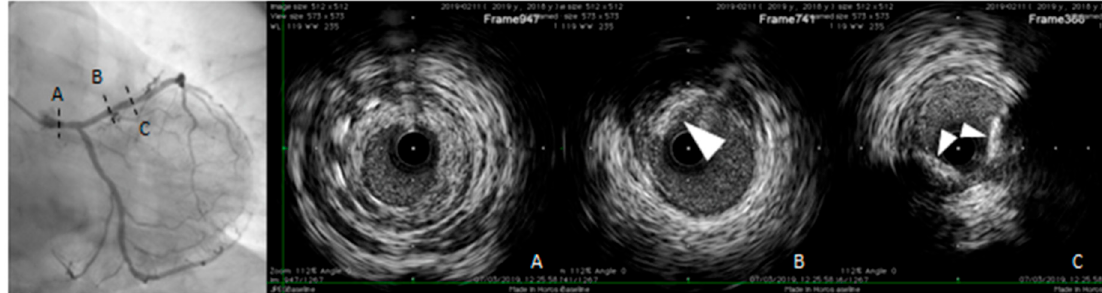
Figure 5. Intravascular ultrasound (IVUS) pull ‐ back in a symptomatic, diabetic female patient with a critical left main stenosis (A, right panel: IVUS frame corresponding to the dotted line A, left panel). Left anterior descending (LAD) presents the diffuse disease with calcific eccentric lesion (triangle arrows B and C right panel, corresponding to the dotted lines B and C left panel). Behind calcifications, shadow does not allow us to obtain complete vessel contours.